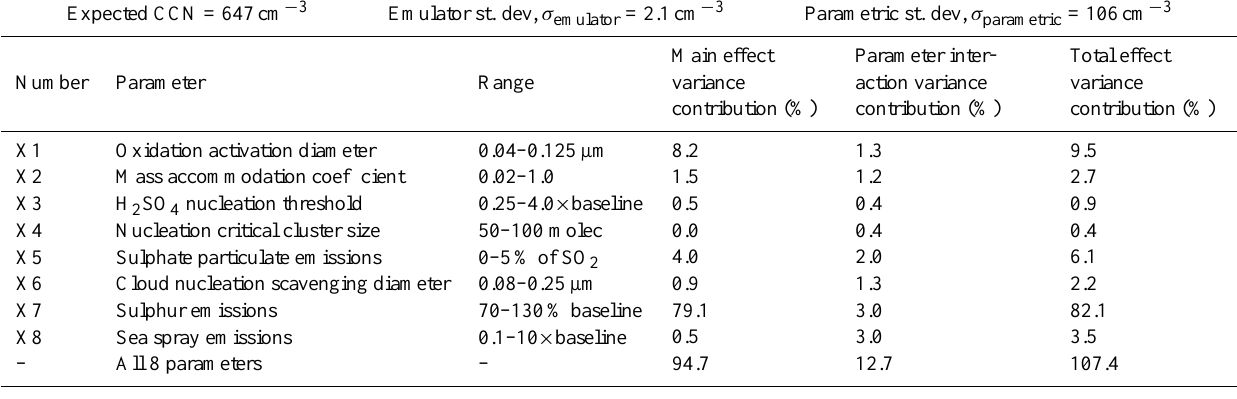
Table 1. Model parameters and their effect on the variance of CCN concentration at the surface in a polluted grid cell covering London (UK).